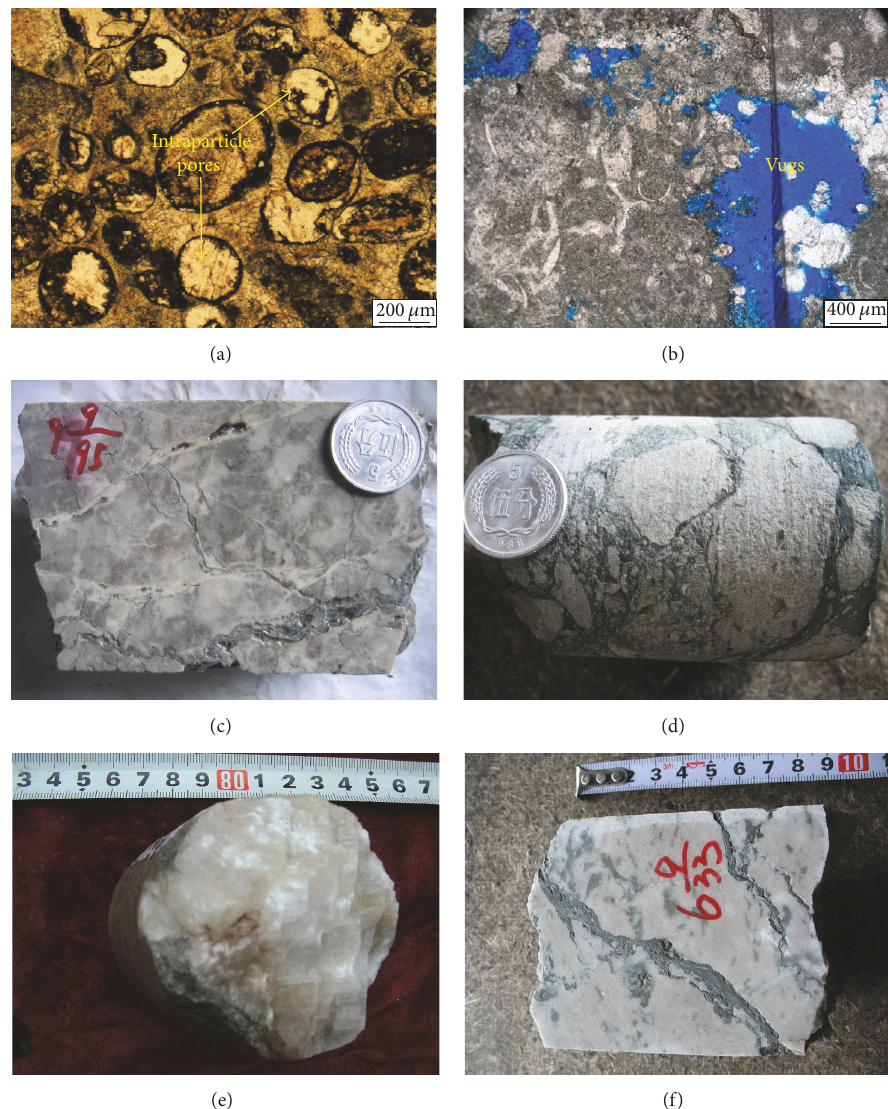
Figure 6: Photographs showing typical diagenetic features in the carbonate rocks of the Lianglitag Fm. (a) Early intragranular dissolution of carbonate minerals developed (most of them were filled during diagenesis), well S111, depth 6108.7 m. (b) Non-fabric-selective dissolution pores and vugs developed, well AD4, depth 6463.42 m. (c) Dissolution vug developed along fractures. Sample from 5794.1 m, well T904. (d) Cavern breccias developed in the Tahe Oilfield, well TH204, depth 5469.2 m. (e) Giant crystal calcite filling the cave. Sample from 6245.95 m, well S116. (f) Fracture filled by green marl in the Tahe Oilfield, well T904, depth 5773.21 m.